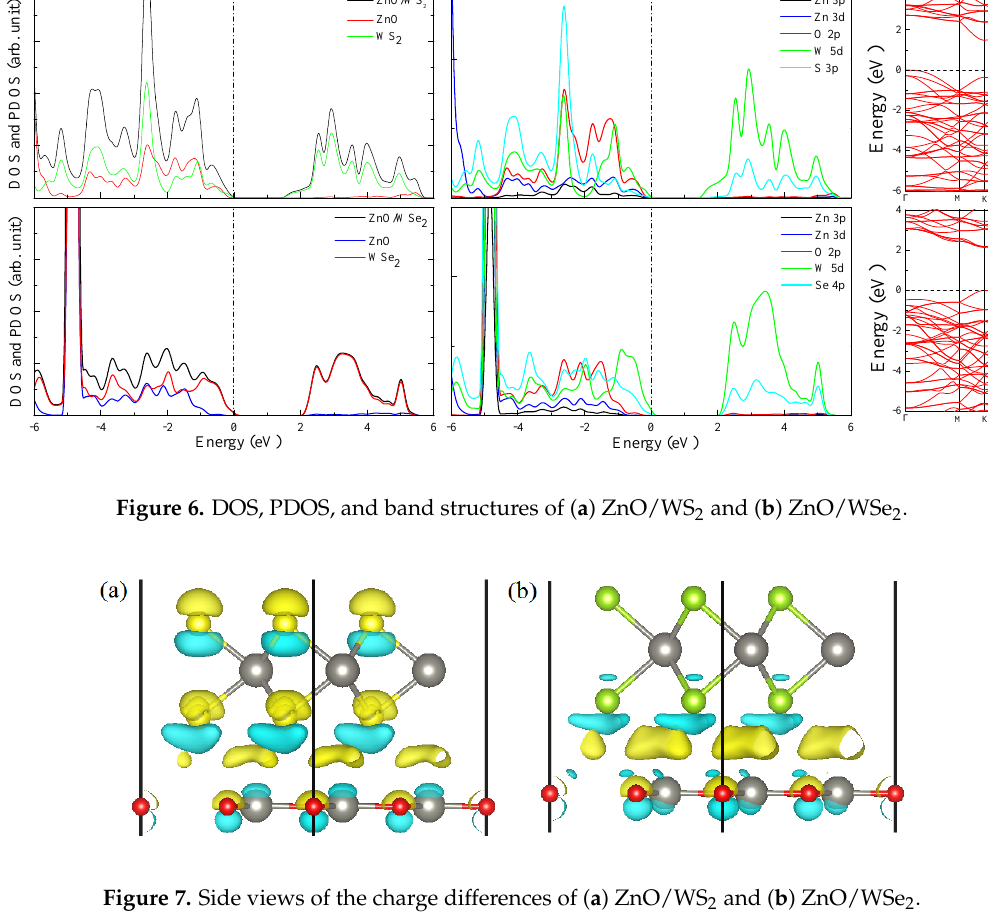
Figure 7. Side views of the charge differences of ( a ) ZnO/WS 2 and ( b ) ZnO/WSe 2